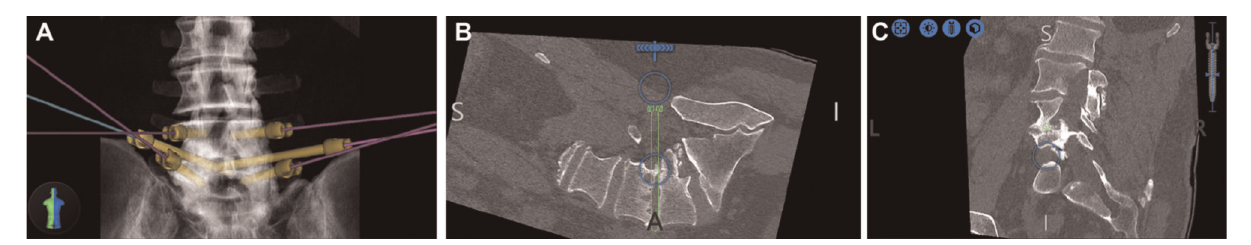
FIGURE 1 | Preoperative plan ( A ) Pedicle screws and bilateral projections into Kambin ’ s triangle were planned. ( B ) The right projection is highlighted in green. ( C ) Coronal plan shows entrance into disc at the mid-pedicle point, which is the largest area of the safe zone within Kambin ’ s triangle (from (16), used with